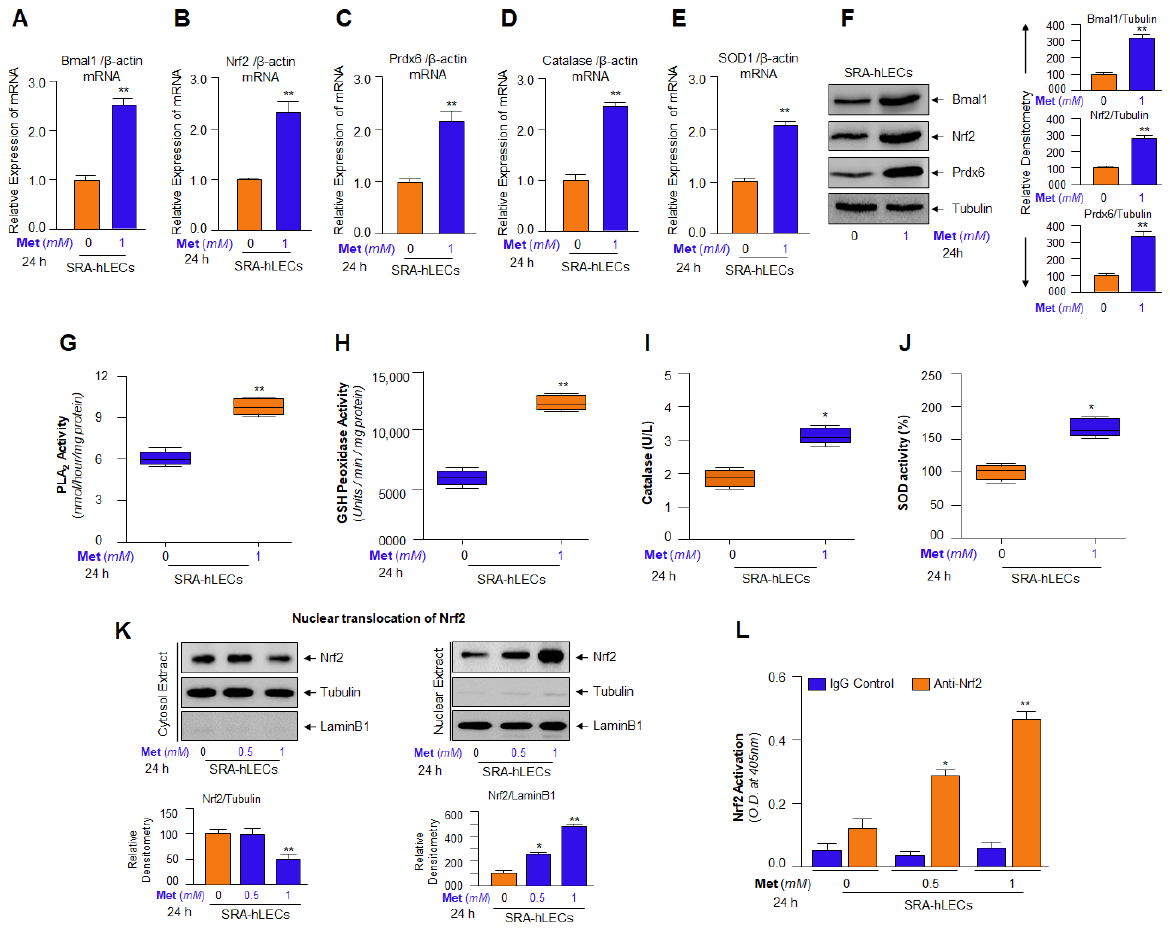
Figure 10. Enhanced Bmal1 and Nrf2-mediated phase II enzymes expression and activities were observed in Metformin-treated SRA-hLECs. ( A – E ) Expression of Bmal1 and Nrf2, and target antioxi- dant genes, Prdx6, Catalase and SOD1 transcripts were increased in Metformin-treated SRA-hLECs. SRA-hLECs (5 × 10 5 ) were cultured in 60 mm culture plate and treated with Metformin as indi- cated. Total RNA was isolated and subjected for mRNA analyses with specific gene primers of the above-noted molecules. Histograms represent the mean ± S.D. from three independent experiments. Untreated vs. Metformin-treated; ** p < 0.001. ( F ) Metformin elevated the expression of Bmal1 and Nrf2, and their target genes, such as Prdx6 in SRA-hLECs. SRA-hLECs (5 × 10 5 ) were cultured in 60 mm culture plate and treated with 1 mM of Metformin for 24 h. Total protein was isolated and subjected for Western analyses using the specific antibodies of the above-noted molecules. Tubulin was used as a loading control. The histogram shows the densitometric analysis of protein bands which was normalized with corresponding tubulin loading control levels. Untreated vs. Metformin-treated; ** p < 0.001. ( G – J ) Enhanced activities of aiPLA 2 , GSH Peroxidase, Catalase and SOD were